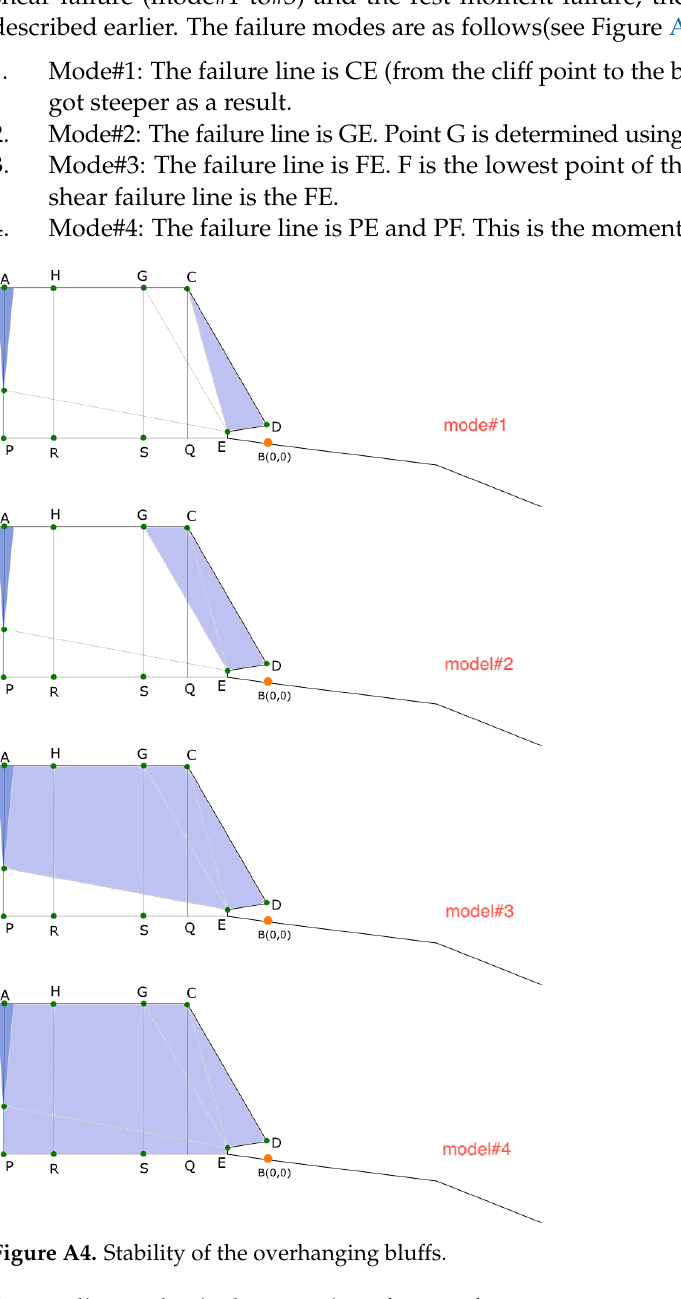
Table A1. Particle size distribution in the study